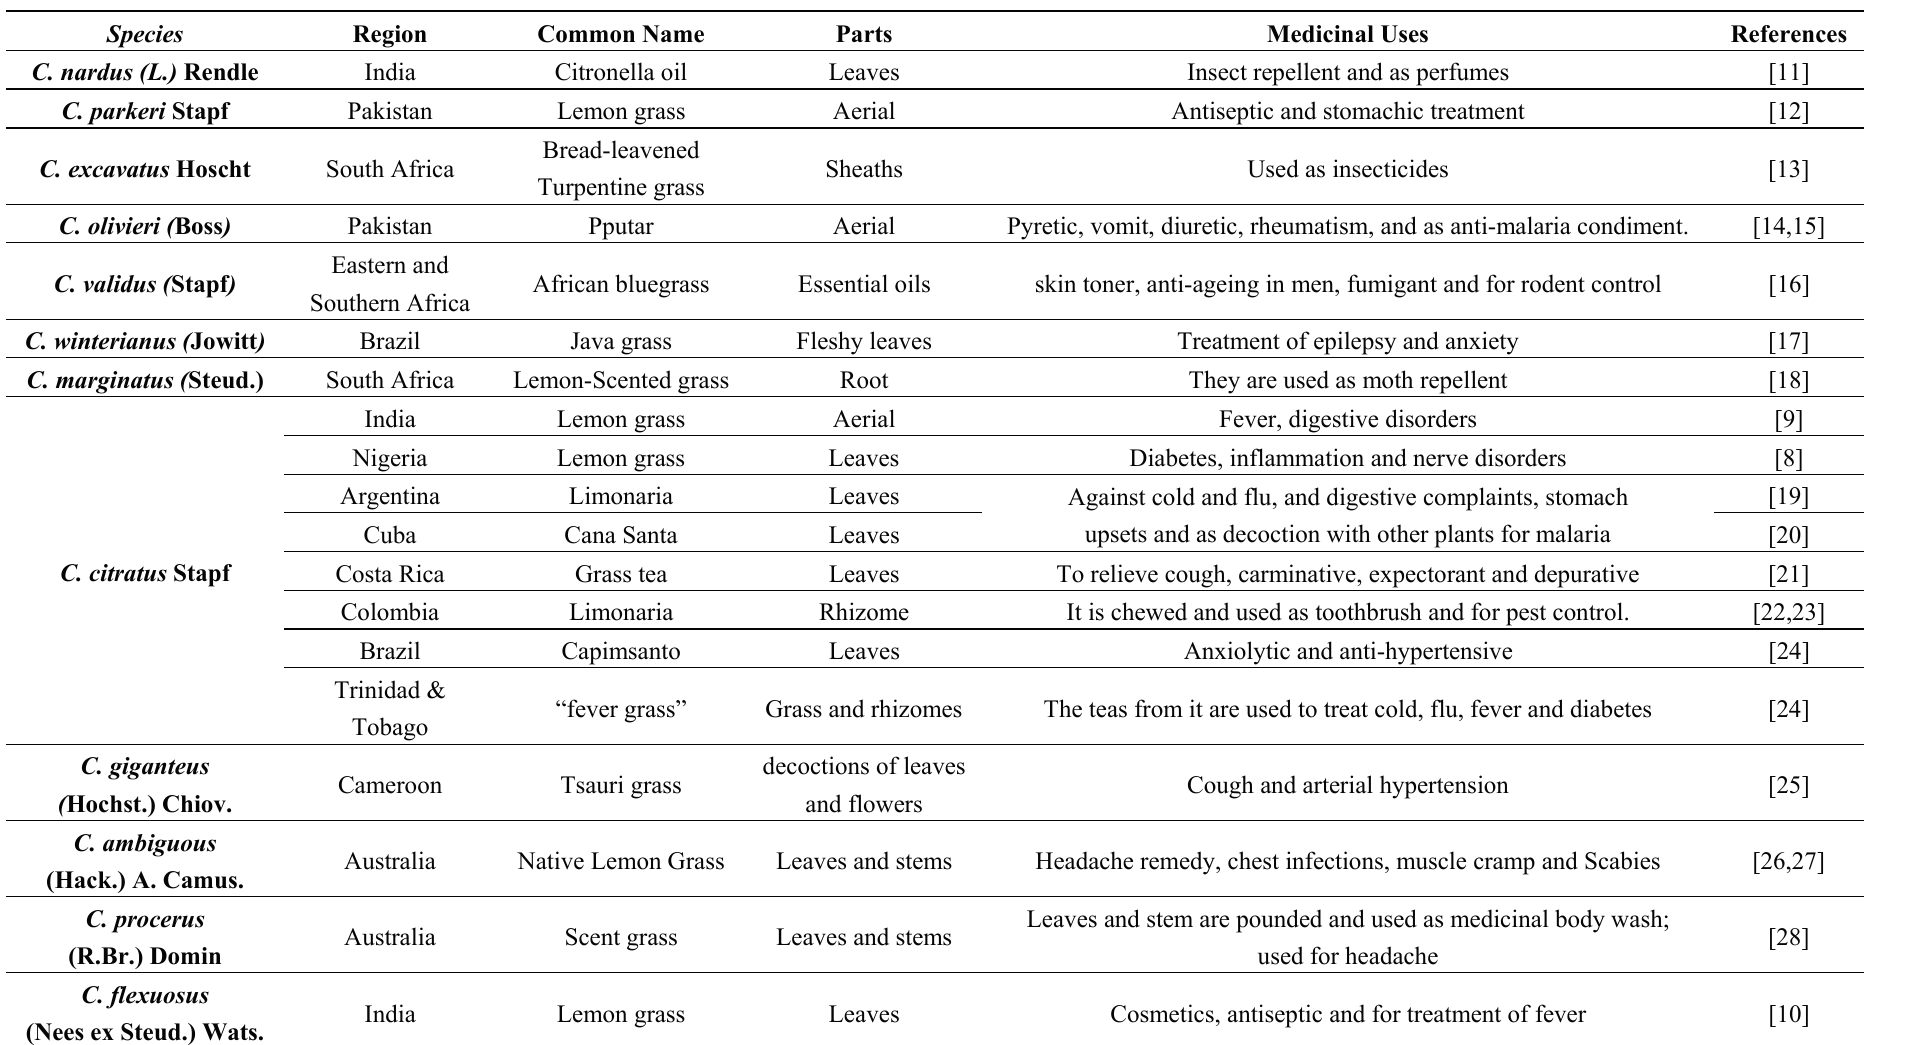
Table 1. Several Cymbopogon species, common name, regions, plant part used and the